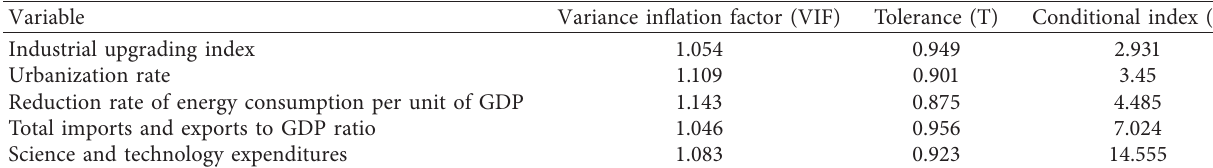
Table 4: Collinearity test of influencing factors.